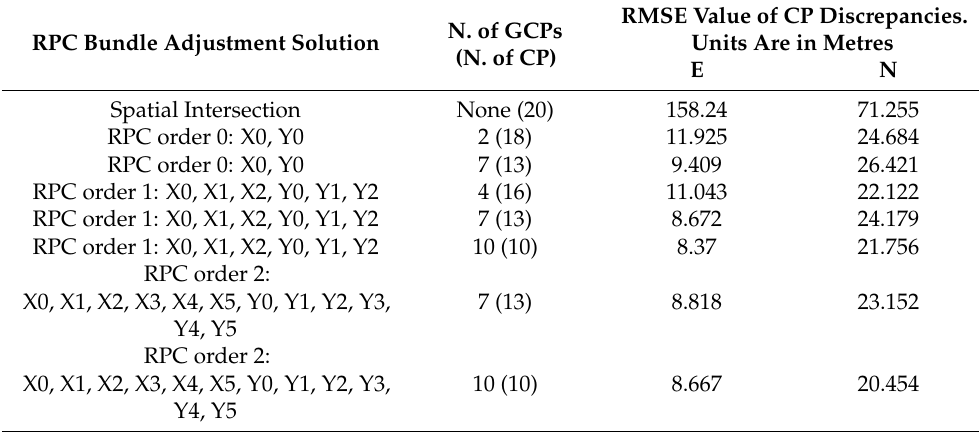
Table A6. Results of RPC bundle adjustment with bias compensation for left strip in N-S direction, case (a).